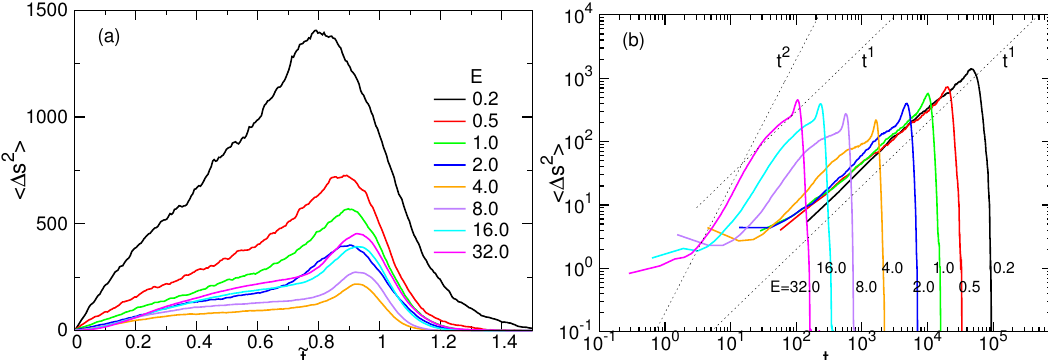
Figure 10. ( a ) Variance of the translocation coordinate (cid:104) ∆ s 2 (cid:105) versus the scaled time ˜ t ; ( b ) (cid:104) ∆ s 2 (cid:105) plotted as a function of the real time t in the log-log plot. The chain has 256 monomers. The field strength E is indicated in the figures.